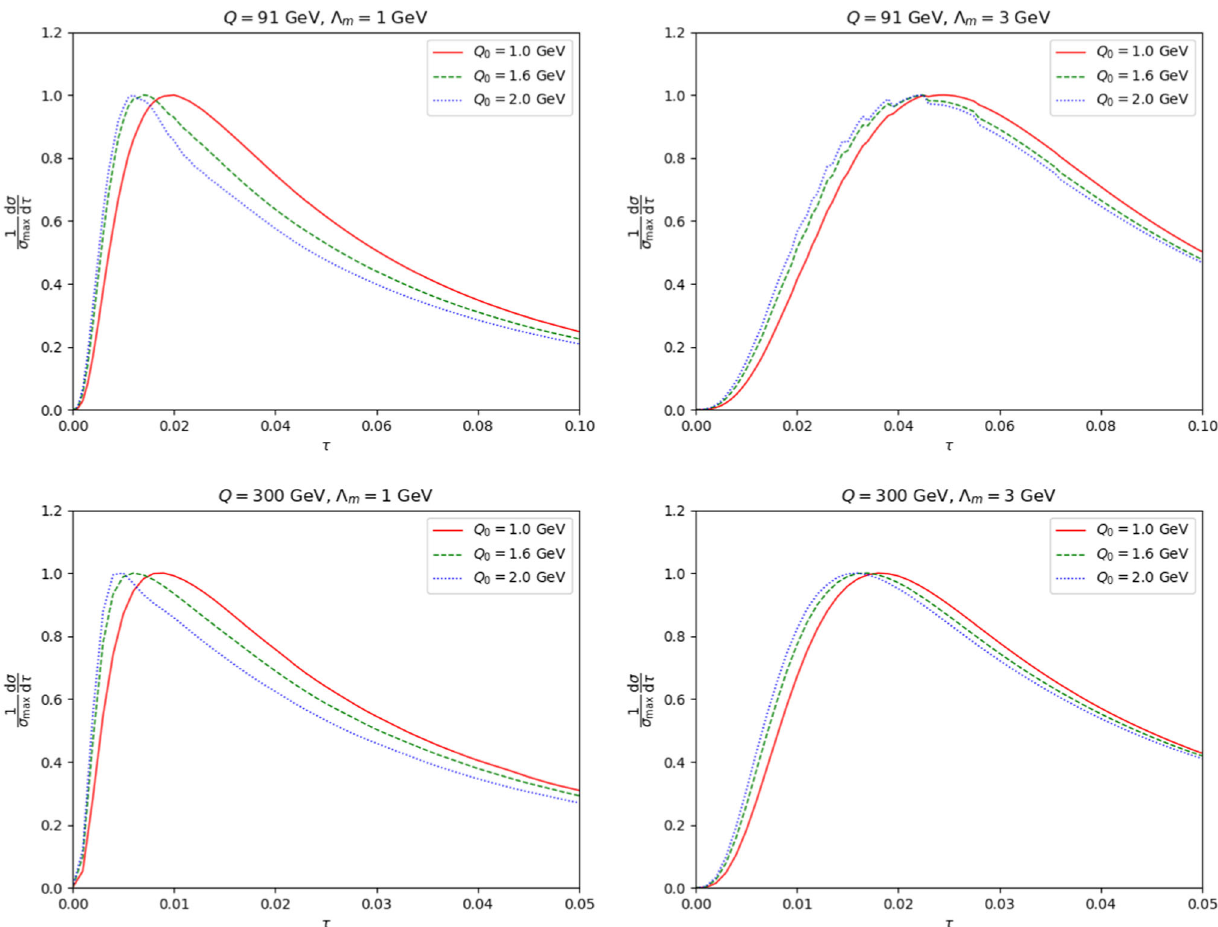
Fig. 2 Plots of the thrust distribution from the dipole shower for the smearing parameters (cid:3) m = 1GeV (left) and (cid:3) m = 3GeV (right) for the a centre-of-mass energies Q = m Z (upper) and Q =